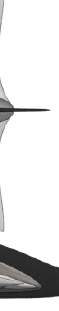
Figure 2. ATAA blimp shaped. Although all ATAA rely on buoyant gas to float, in some environments, the use of lift forces of a wing and the control of a tail to govern the ATAA position may be neces- sary. So, several shapes are to be considered depending on the installation environment or portability needs. The ATAA wireless data network nodes mesh is connected to one or more Ground Connection Points (GCP) installed in one or more geographical areas or over a satellite, which provide a point of connection to the DNIHSS Network Managing Services (NMS). The NMS are responsible for managing the DNIHSS infrastructure ’s operation and secu- rity. The NMS also interconnects the HSS modules in its network to its corresponding managing systems in the cloud. Several goals were determined for the proposed DNIHSS and its components in or- der to ensure independence and security to the supported HSS: •